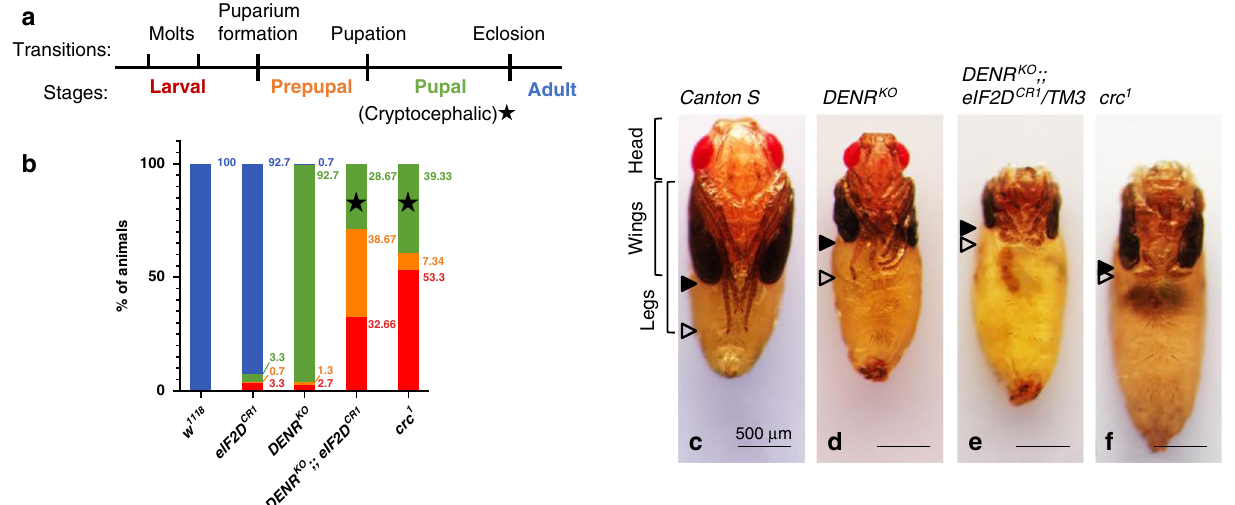
Fig. 4 DENR eIF2D double mutants resemble ATF4 mutants. a Schematic of developmental transitions during the Drosophila life cycle. b Lethal phase analysis for control, eIF2D , DENR , DENR eIF2D double, and crc animals. Developmental stages are color-coded as shown in the schematic in a . Star symbol indicates animals that arrest during metamorphosis as cryptocephalic pupae. n = 150 for each genotype. c – f Analysis of pupal morphology in dissected control ( Canton S) , DENR , DENR eIF2D/TM3 , and crc mutant animals. Solid arrowheads indicate the degree of wing extension and outlined arrowheads indicate the extent of leg extension. An extended analysis of lethal phase and animal morphology can be found in Supplementary Information (Extended analysis of lethal phase and animal morphology). Data in c – f are representative images collected from two independent biological experiments with ten animals in each trial. Scale bars are 500 μ